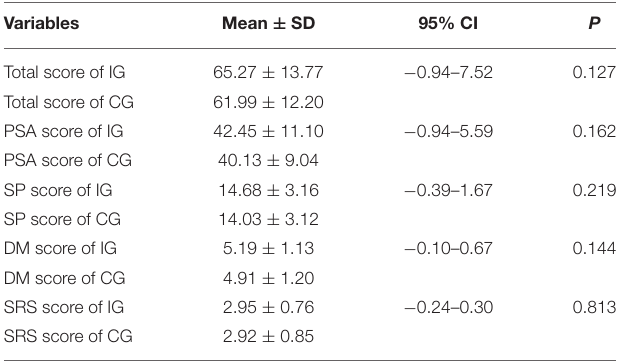
TABLE 2 | Baseline levels of total and subscales scores of patients with vitiligo in the intervention group and the control